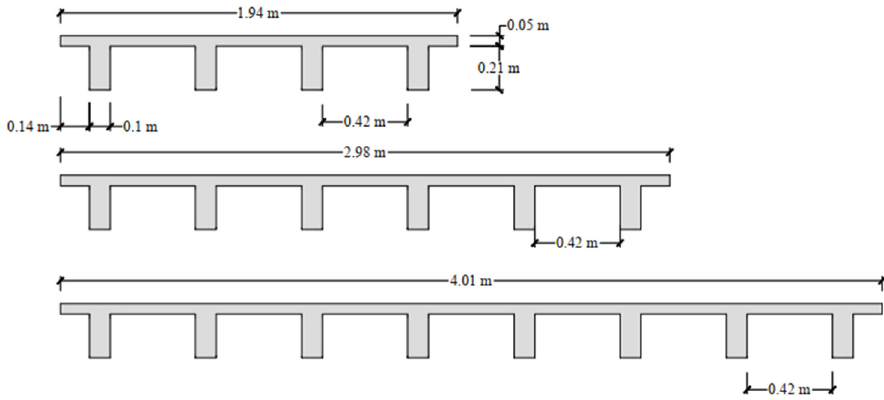
Figure 7. A schematic of the decks with different widths used in the present study.